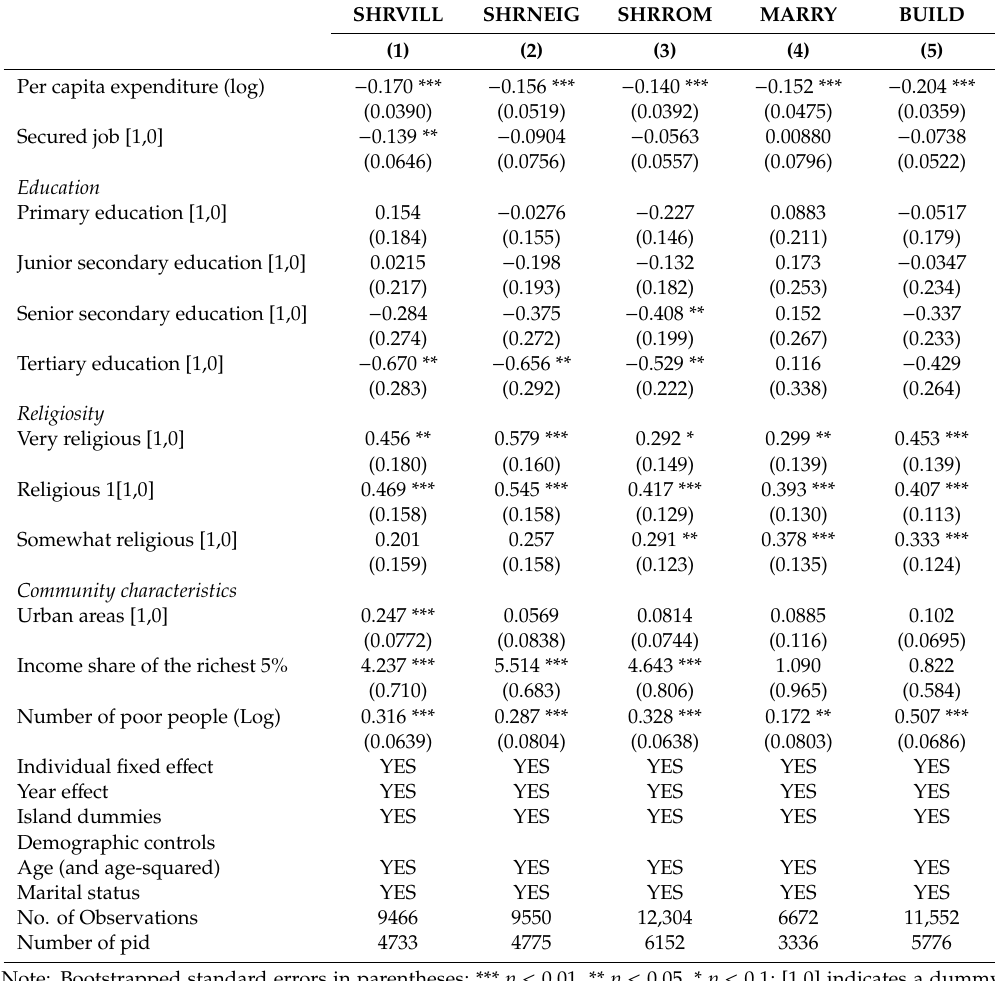
Table A3. Regression results (Fixed-e ff ect conditional logit Model), Richest